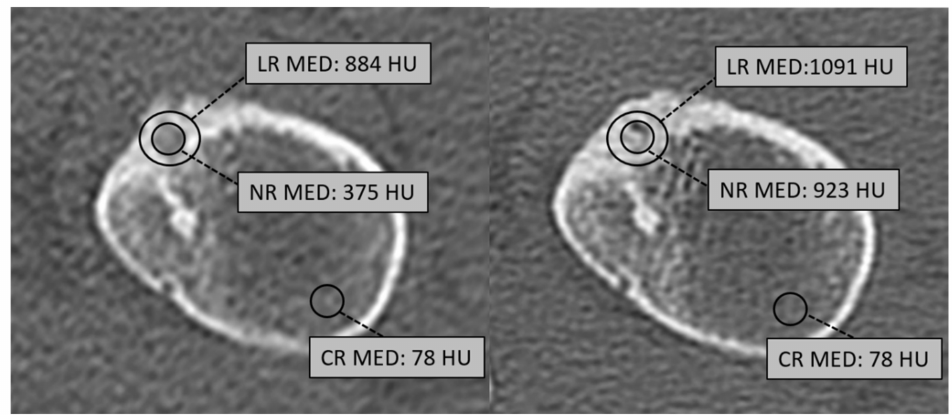
Figure 1. We manually traced, in the most reproducible way, three different ROIs for nidus (Nidus ROI, NR), whole lesion with perilesional sclerosis (Lesion ROI, LR) and a control area (Control ROI, CR) on a nearby normal trabecular bone